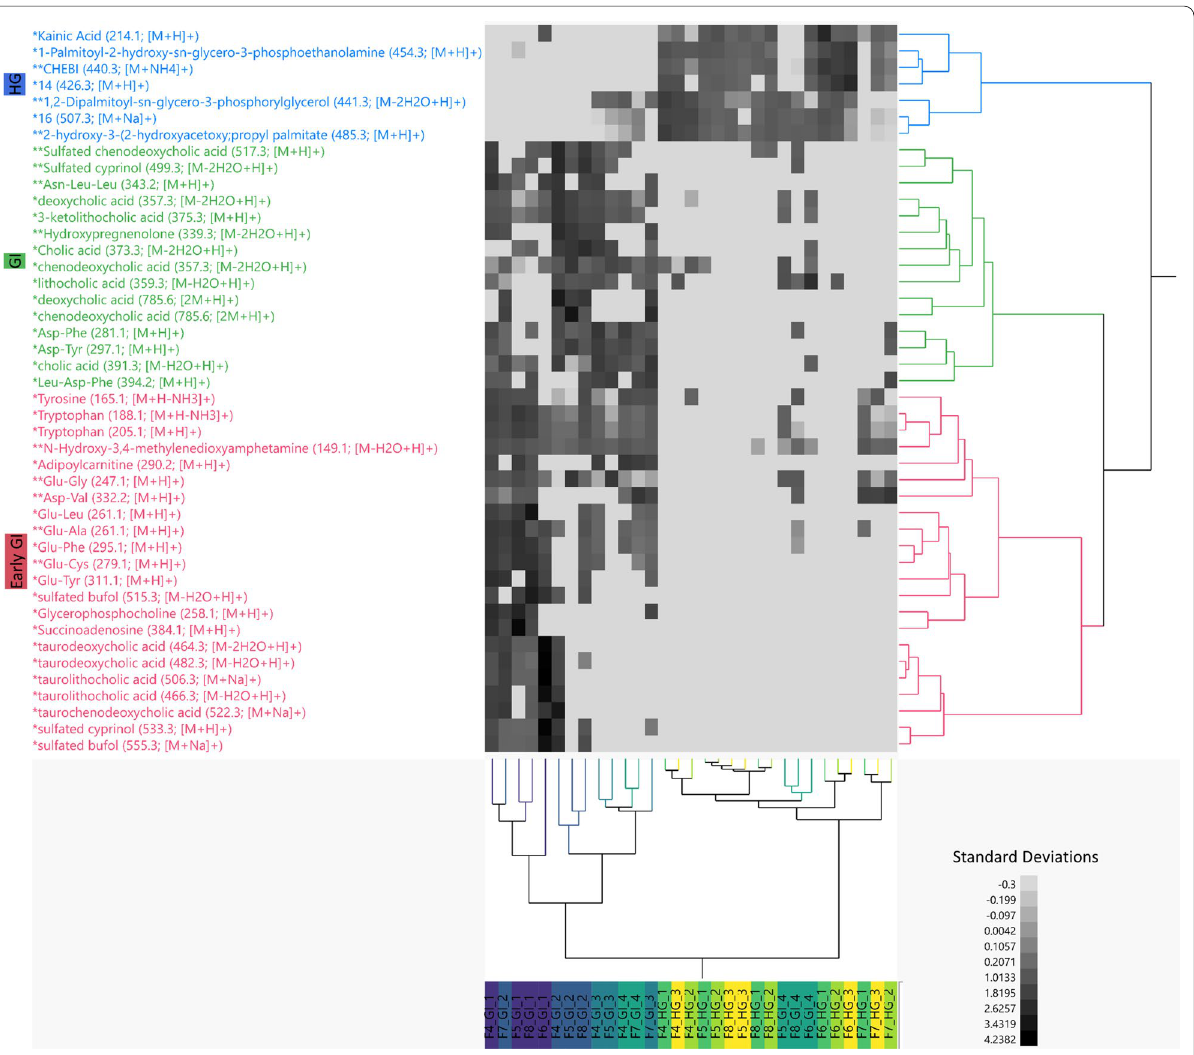
Fig. 6 Enrichment between samples of the 44 most abundant metabolites that responded significantly to gut subsection (adjusted p-value and had known library or analog IDs. Metabolite relative abundances were arcsine squareroot transformed and z-scored to generate a two-way heatmap. Samples are clustered on the x axis and metabolites are clustered on the y axis. Metabolites are labeled by their library and/or analog ID, with one asterisks indicating a match class level 2 (library ID) and two asterisks indicating a match class level 3 (analog ID). M/z values and molecular adducts are indicated in parenthesis after each feature name. Metabolites are broadly clustered into 3 modules of enrichment (CCC corresponding to “Early GI,” “GI,” and “HG.” Metabolites are colored according to these clusters and samples on the x axis are color coded according to gut